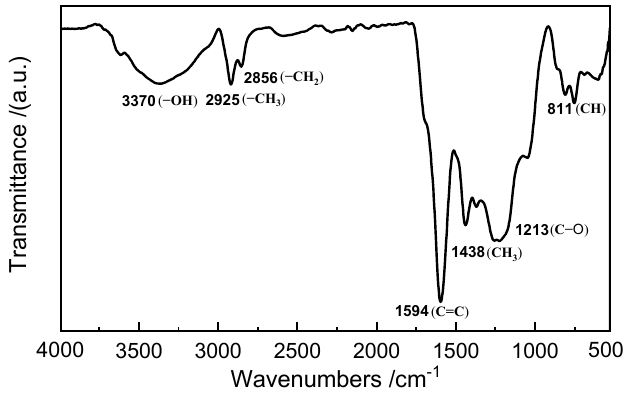
Figure 1. FTIR of raw